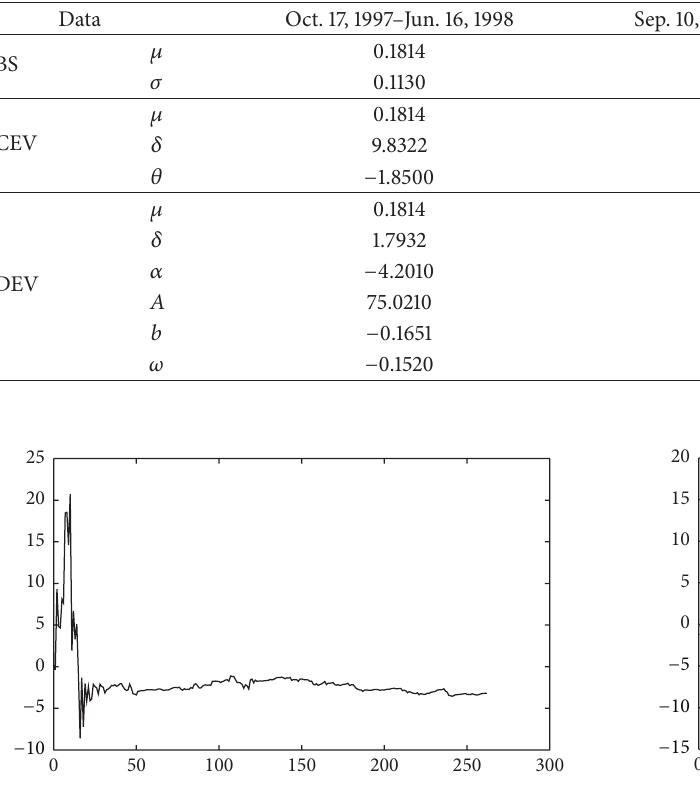
Figure 3: Values of 𝑓(𝑡) during subprime crisis.